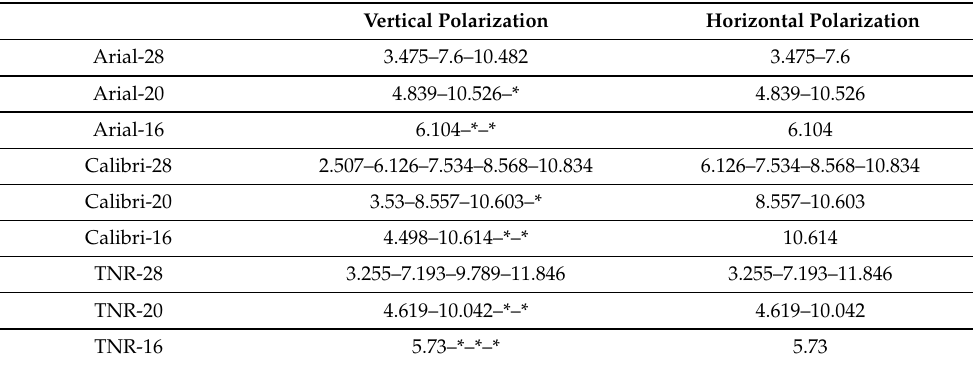
Table 10. Signature resonance frequencies for letter tag (cid:240) with various font types and sizes (* repre- sents resonant frequency out of analyzed frequency range).